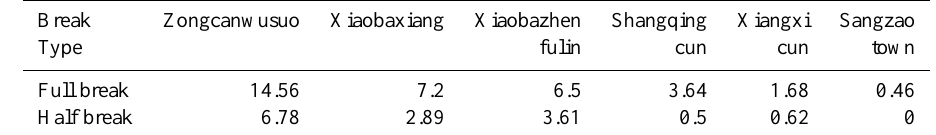
Fig. 5. (a) Boundary of the Xiaojiaqiao barrier lake on 19 May 2008. (b) The boundary of the dammed lake overlapped with a 765m contour line in the 3-D scene. Table 3. Maximum inundation depths at different locations for the Xiaojiaqiao landslide (Unit: m).